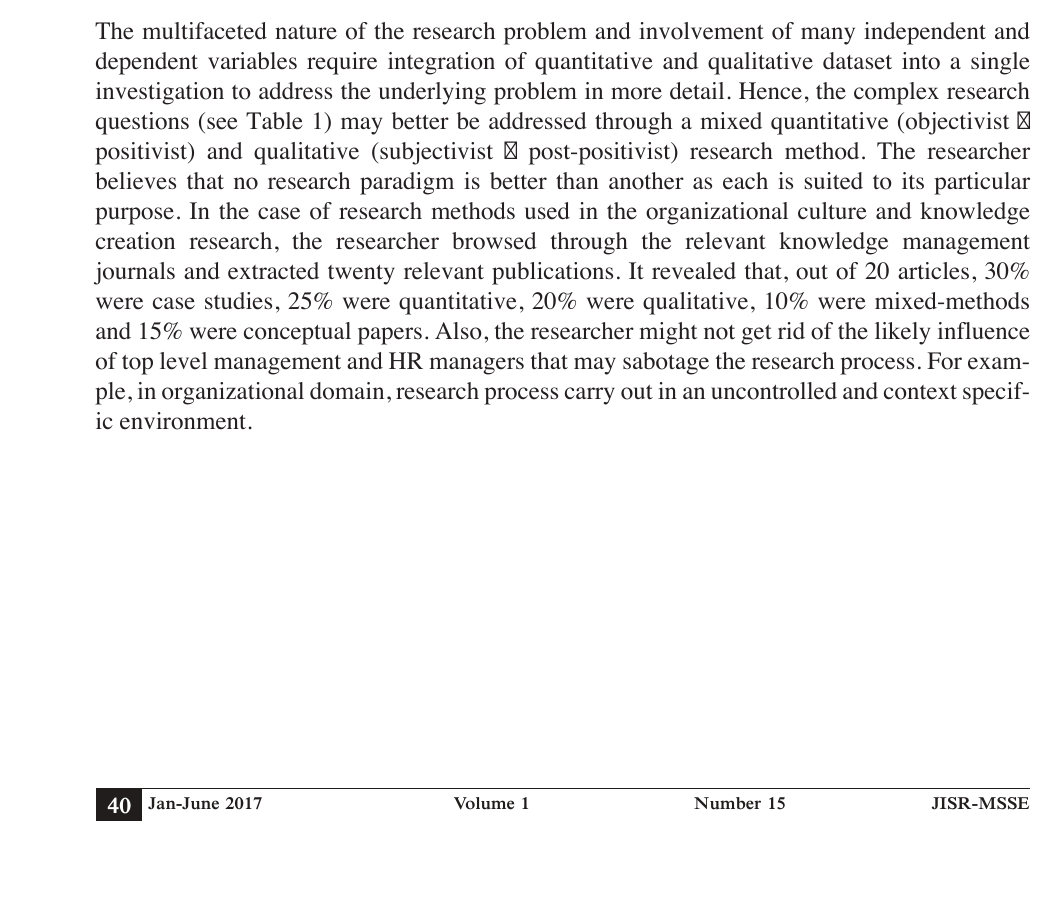
Figure 3. Research Methods in KM Research – Wallace et al